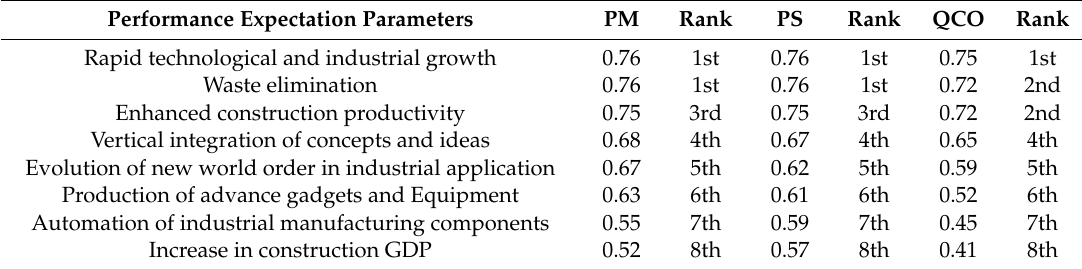
Table 14. Performance expectation of lean thinking and Industry 4.0 in the construction industry. Performance Expectation Parameters Rapid technological and industrial growth